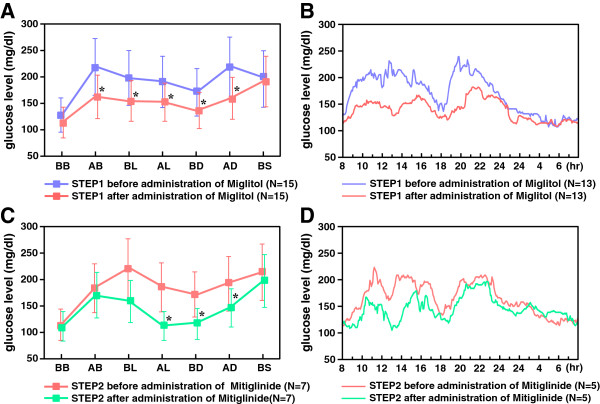
Median 7-point SMBG and CGM at STEP 1 and STEP 2. A. Median 7-point SMBG of patients who proceeded to STEP 1 (before and after administration of Miglitol). Blue line: The patients who proceeded to STEP 1 before administration of Miglitol, Red line: The patients who proceeded to STEP 1 after administration of Miglitol. BB: before breakfast, AB: after breakfast, BL: before lunch, AL: after lunch, BD: before dinner, AD: after dinner, BS: before sleep. *value of SMBG of patients who proceeded to STEP 1 before vs. after administration of Miglitol P < 0.05. B. Median CGM of patients who proceeded to STEP1 (before and after administration of Miglitol). Blue line: The patients who proceeded to STEP1 before administration of Miglitol, Red line: The patients who proceeded to STEP1 after administration of Miglitol. C. Median 7-point SMBG of patients who proceeded to STEP 2 (before and after administration of Mitiglinide). Red line: The patients who proceeded to STEP 2 before administration of Mitiglinide, Green line: The patients who proceeded to STEP 2 after administration of Mitiglinide. BB: before breakfast, AB: after breakfast, BL: before lunch, AL: after lunch, BD: before dinner, AD: after dinner, BS: before sleep. *value of SMBG of patients who proceeded to STEP 2 before vs. after administration of Mitiglinide P < 0.05. D. Median CGM of patients who proceeded to STEP 2 (before and after administration of Mitiglinide). Red line: The patients who proceeded to STEP 2 before administration of Mitiglinide. Green line: The patients who proceeded to STEP 2 after administration of Mitiglinide.